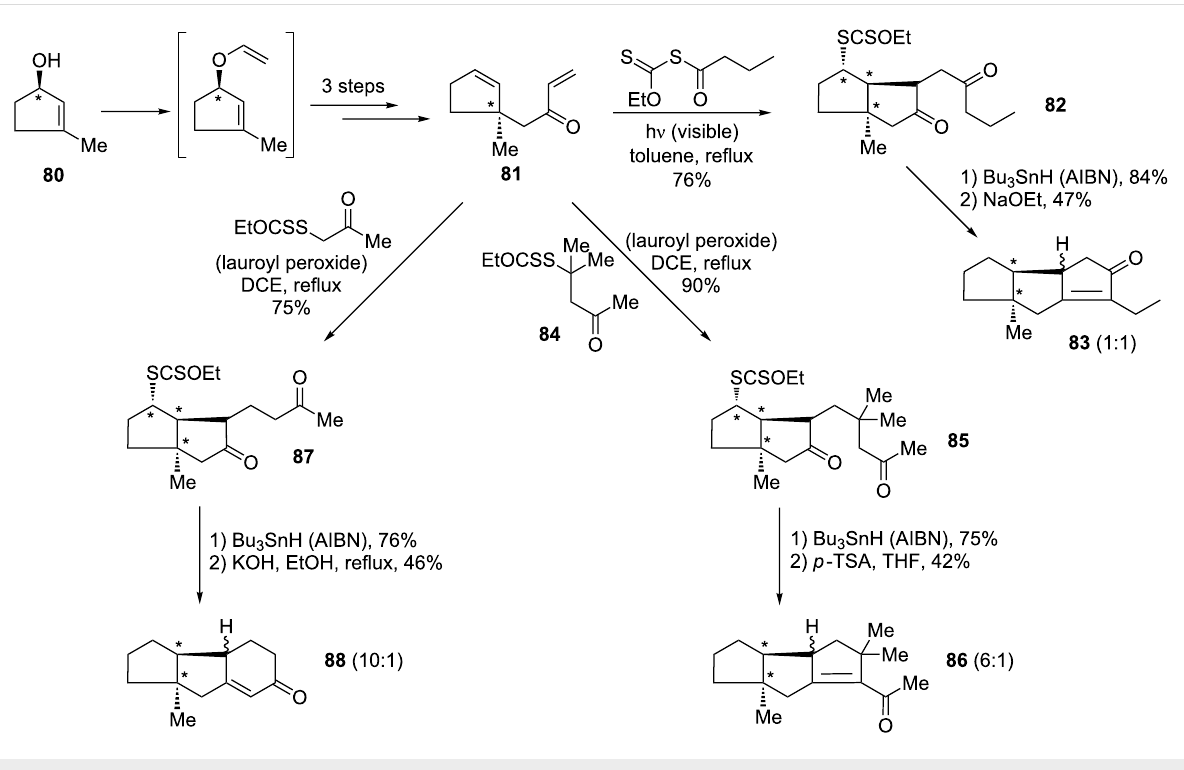
Scheme 17: Rapid assembly of